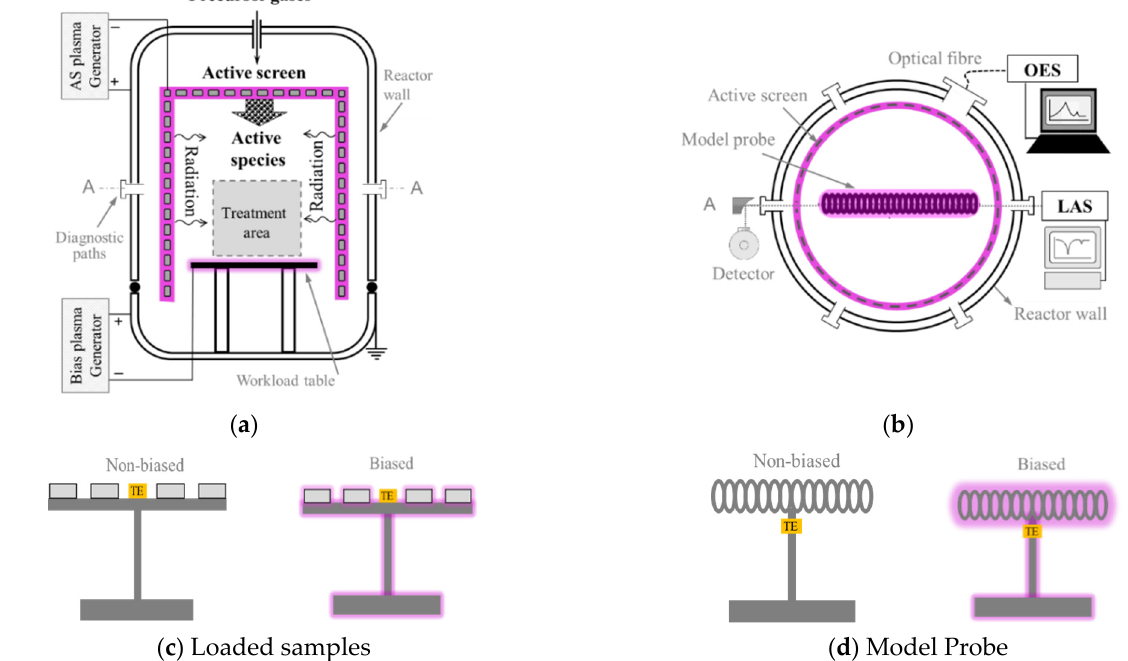
Figure 1. Schematic diagrams of the industrial-scale cold-wall ASPNC reactor ( a ), the plasma diagnostics setup ( b ), a loaded sample platform for material treatments ( c ), and a model probe for plasma diagnostics ( d ) placed at the treatment area (indicated by the dash line) in the centre of the reactor. TE indicates the positions of the thermocouples and A is the beam path.